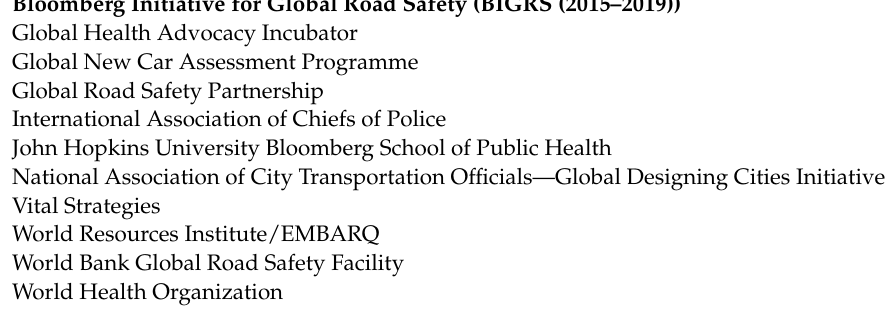
Table A1. Relative Risks for the Behavioural Risk Factors Used in the GRSP (2010–2014) and BIGRS (2015–2019): Social Marketing Campaigns, Police Enforcement, and Related Road Safety Activities. Initiative Relative Risks Drunk driving by blood alcohol concentration level: